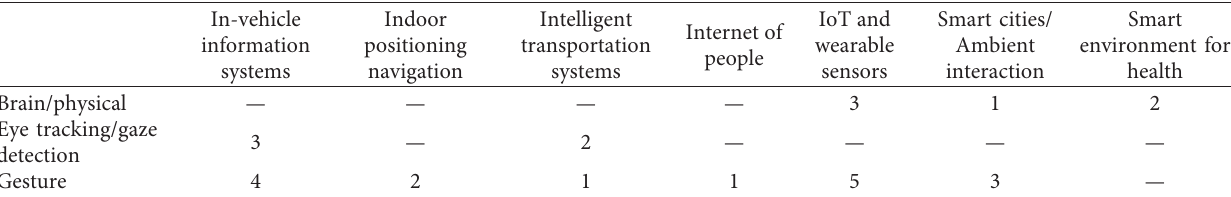
Table 10: Relationship between UbiComp and ambient intelligence studies with nontraditional interfaces for studies evaluated with standardized